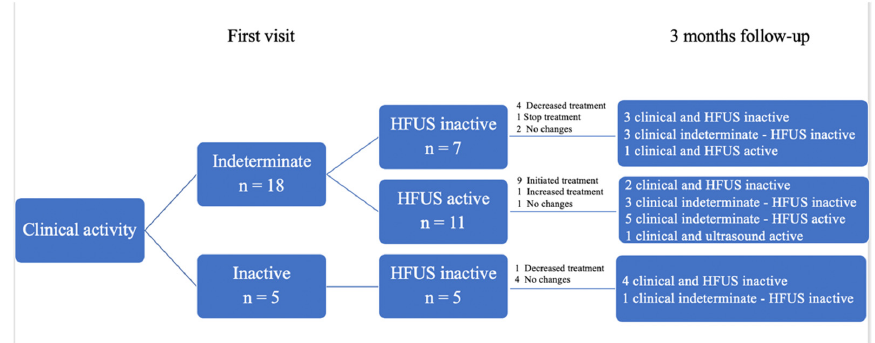
Figure 1. Usefulness of HFUS in therapeutic decision-making at first visit and 3-month follow-up. HFUS: High-frequency Ultrasound.